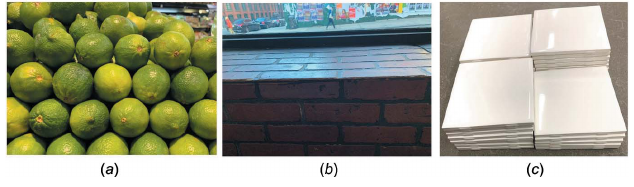
Figure 1 Three macro-world illustrations that were found during one afternoon in Brooklyn. ( a ) Fm 3 m limes, ( b ) Cmmm bricks, ( c ) P 4 mm ceramic tiles. Gravity has a way of squeezing out groups that are in the main organized on glide-planes or screw